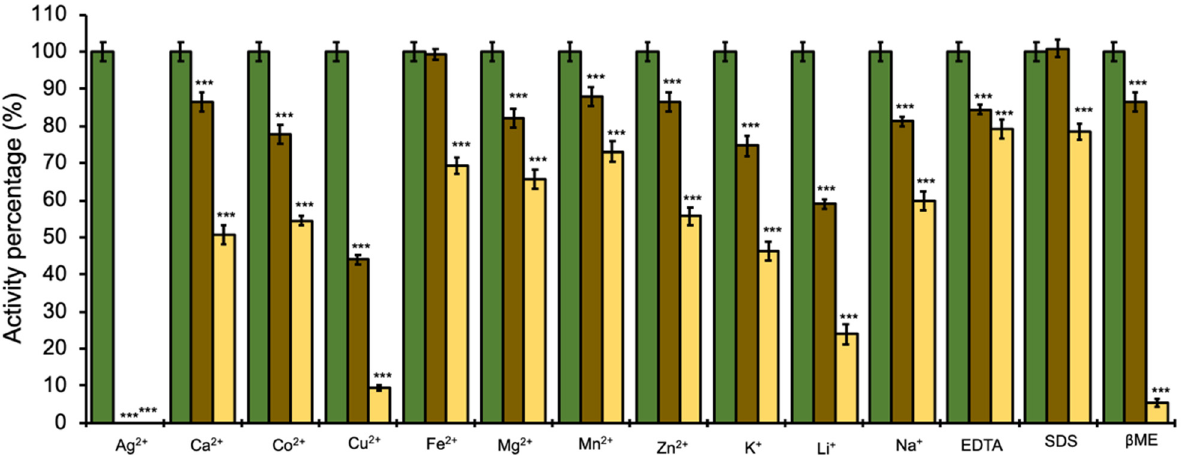
Figure 4. Effect of metal ions and chemical substances on the activity of β -xylosidase SRBX1 from S. reilianum : green: 0 mM; brown: 2 mM; and yellow: 10 mM. *** p < 0.001. EDTA: ethylenediaminetet- raacetic acid; SDS: sodium dodecyl sulfate; and β ME: β -mercaptoethanol.